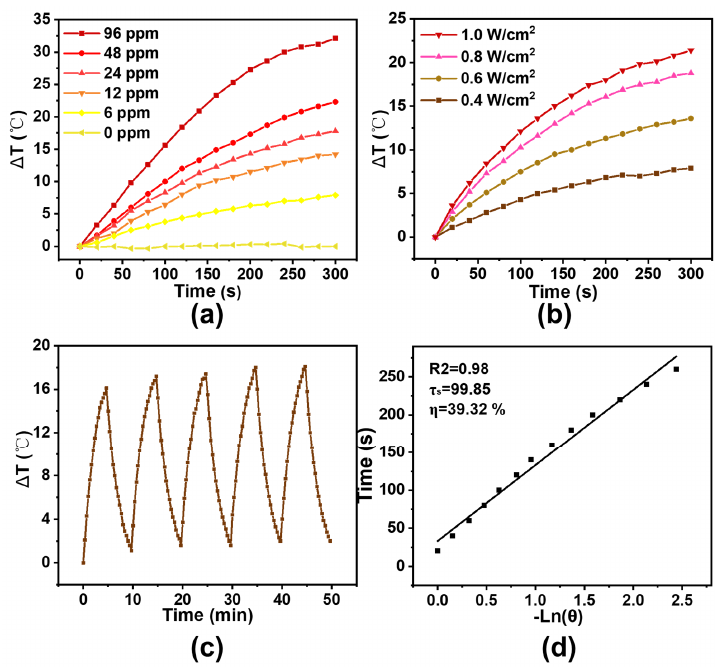
Figure 2. Photothermal conversion efficiency and photothermal stability of CuS − BSA. ( a ) Relative temperature profiles of CuS − BSA with different Cu concentrations (0, 6, 12, 24, 48, 96 ppm) under NIR laser at 0.8 W/cm 2 for 5 min. ( b ) Relative temperature profiles of CuS − BSA with 24 ppm of Cu at different power density (0.4, 0.6, 0.8, 1.0 W/cm 2 ) for 5 min. ( c ) Temperature curve of 0.8 W/cm 2 laser irradiation on/off cycles of CuS − BSA with 24 ppm of Cu. ( d ) Calculation of the photother ‐ mal − conversion efficiency ( η ) of CuS − BSA under an 808 nm laser. 0.8 W/cm 2 laser irradiation on/off cycles of CuS–BSA with 24 ppm of Cu. ( d ) Calculation of